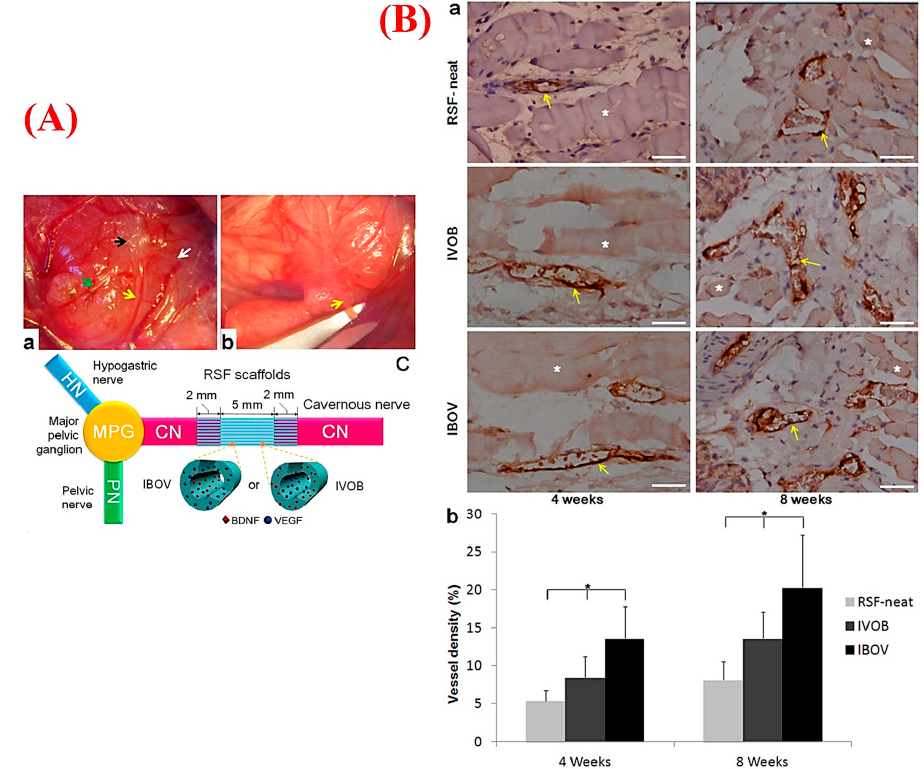
Figure 5. ( A ) Macroscopic views representing the implantation of regenerated silk fibroin (RSF) scaffolds into a rat animal model: (a) exposed major pelvic ganglion (MPG), pelvic nerve (PN), hypogastric nerve (HN), and cavernous nerve (CN) are marked as black, green, white, and yellow arrows, respectively; (b) creating the CN gap (arrow) (length of 5 mm) by scissors; and (c) schematic illustration of suturing process of RSF scaffolds and two CN ends. ( B ) Immunohistochemistry (IHC) staining of the harvested samples for evaluating new vessels in the retrieved scaffolds of RSF-neat, inner-VEGF/outer-brain-derived neurotrophic factor (BDNF) (IVOB), and inner-BDNF/outer-VEGF (IBOV) after 4 and 8 weeks of implantation (a), in which the asterisk (*) shows the scaffold fragments and the yellow arrows show vessels (bar: 100 μ m); and (b) graph showing the vessel densities in (a) in which the asterisk (*) shows significant differences among the groups at each time point ( p < 0.05). Adapted from Zhang et al. [274] , with permission from American Chemical Society.